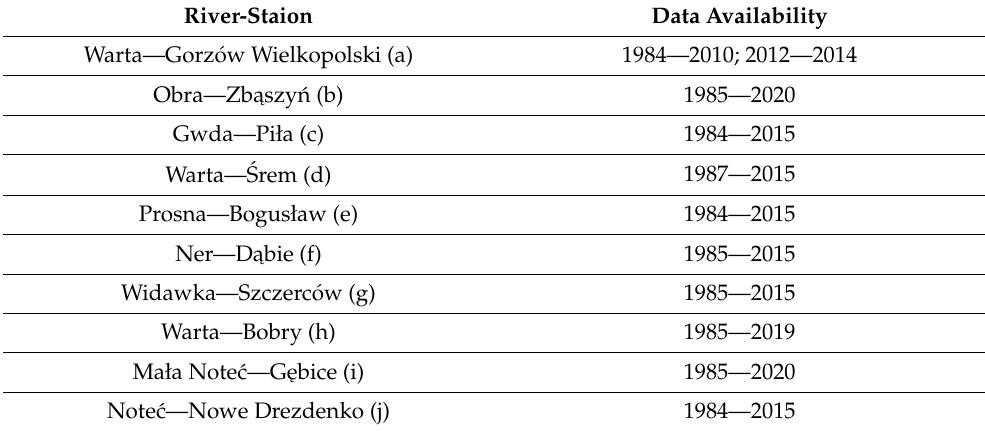
Table 2. Scope of the available data on river water temperatures. River-Staion Data